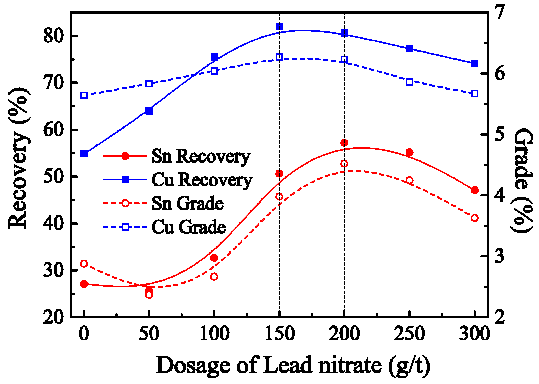
Figure 7. Flotation recovery and grade of Sn and Cu as a function of the dosage of lead nitrate (pH = 7.2~7.5; CMC 350 g/t; SSF 250 g/t; BHA 2000 g/t; terpineol 25